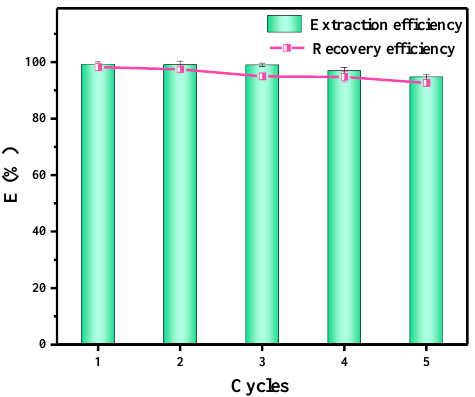
Figure 7. Adsorption of Pd (II) by PS-DMTD in the adsorption – desorption cycle. m PS-DMTD = 0.040 g, C Pd (II) = 100 mg/L, pH = 1.0, T = 298.15 K, t = 240 min, and V = 0.02 L. C Pd (II) = 100 mg/L, pH = 1.0, T = 298.15 K, t = 240 min, and V = 0.02